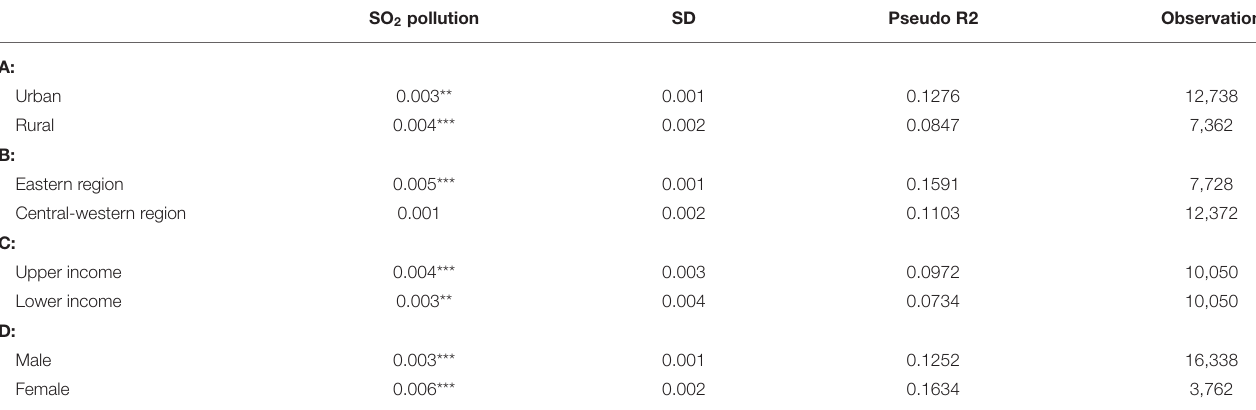
TABLE 4 | Results of heterogeneity effect.